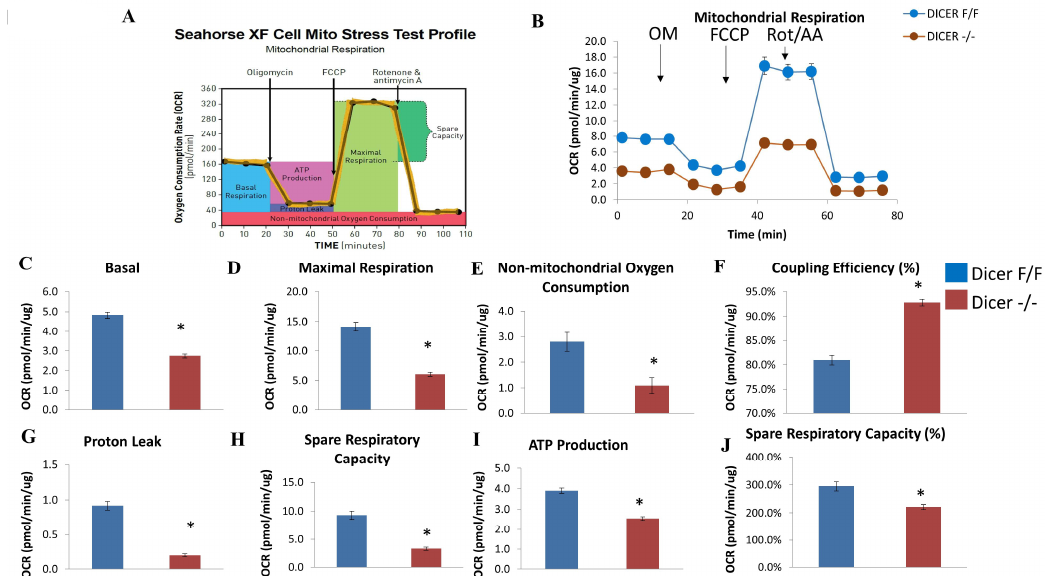
Figure 3. Assessment of oxygen consumption rate (OCR) in Dicer F / F and Dicer − / − C-MSC. ( A ) Schematic representation of the protocol employed in data collection and calculations of mitochondrial respiration. ( B ) Normalized OCR data. ( C – J ) Measurements of mitochondrial respiration calculated from the OCR tracing in ( B ). Results are normalized to total cellular protein and shown as mean ± SEM ( n = 8), * p < 0.05. OM: Oligomycin; FCCP: carbonylcyanide 4-(trifluoromethoxy)- phenylhydrazone; Rot / AA: Rotenone & antimycin A.